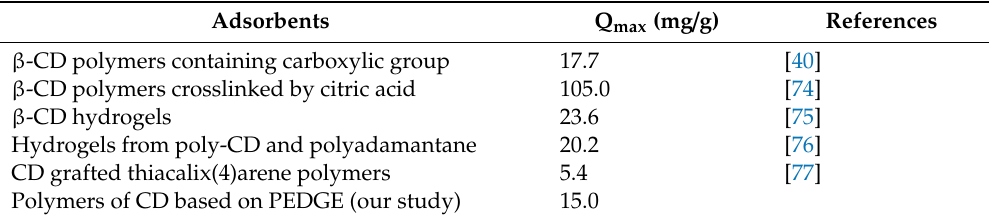
Table 3. Maximum adsorption capacities of MB for various β -CD-based polymers based on the Langmuir